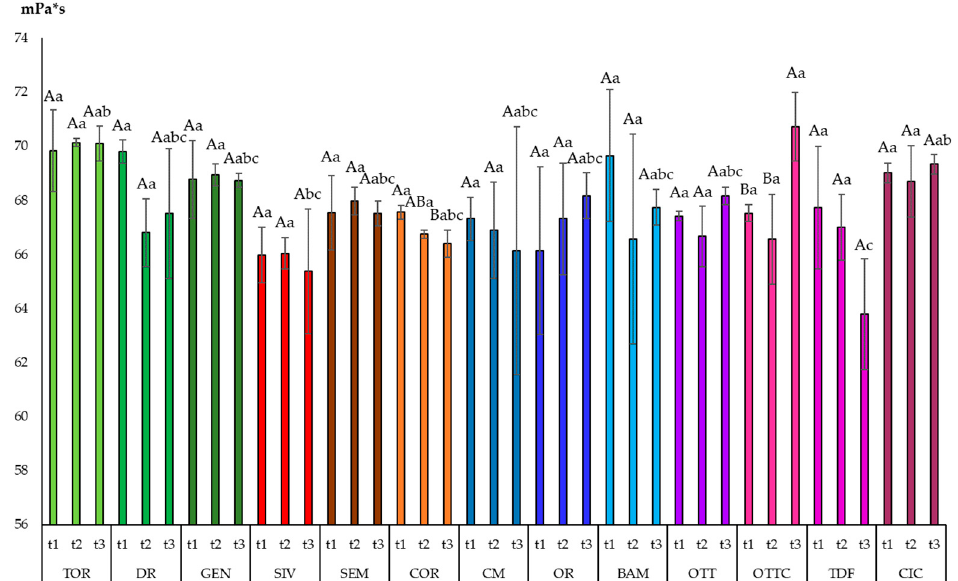
Figure 2. Viscosity of 13 olive oils from minor Italian cultivars harvested at three different maturation stages. Data are expressed as the mean of three replicates ± standard deviations. Different capital letters, between the three harvesting times for the same cultivar, indicate significant differences ( p < 0.05). Different small letters, at the same harvesting time for the different cultivars, indicate significant differences ( p < 0.05).